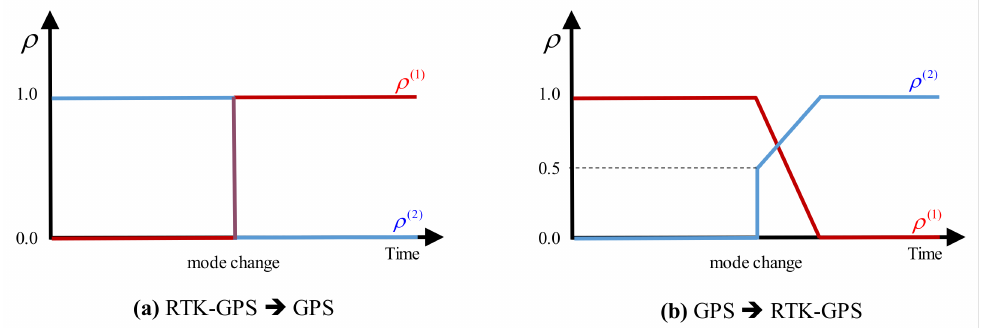
Figure 8. Smooth mode